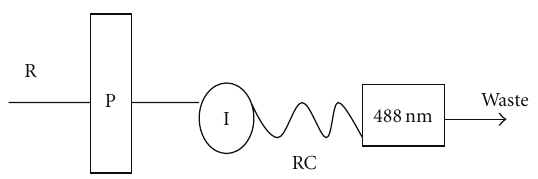
Figure 1: Block diagram for the FIA setup used for determination of nickel using